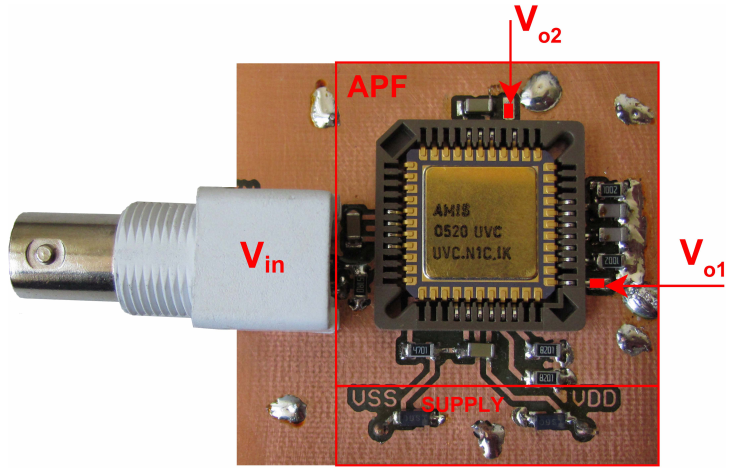
Figure 3. Developed printed circuit board (PCB)